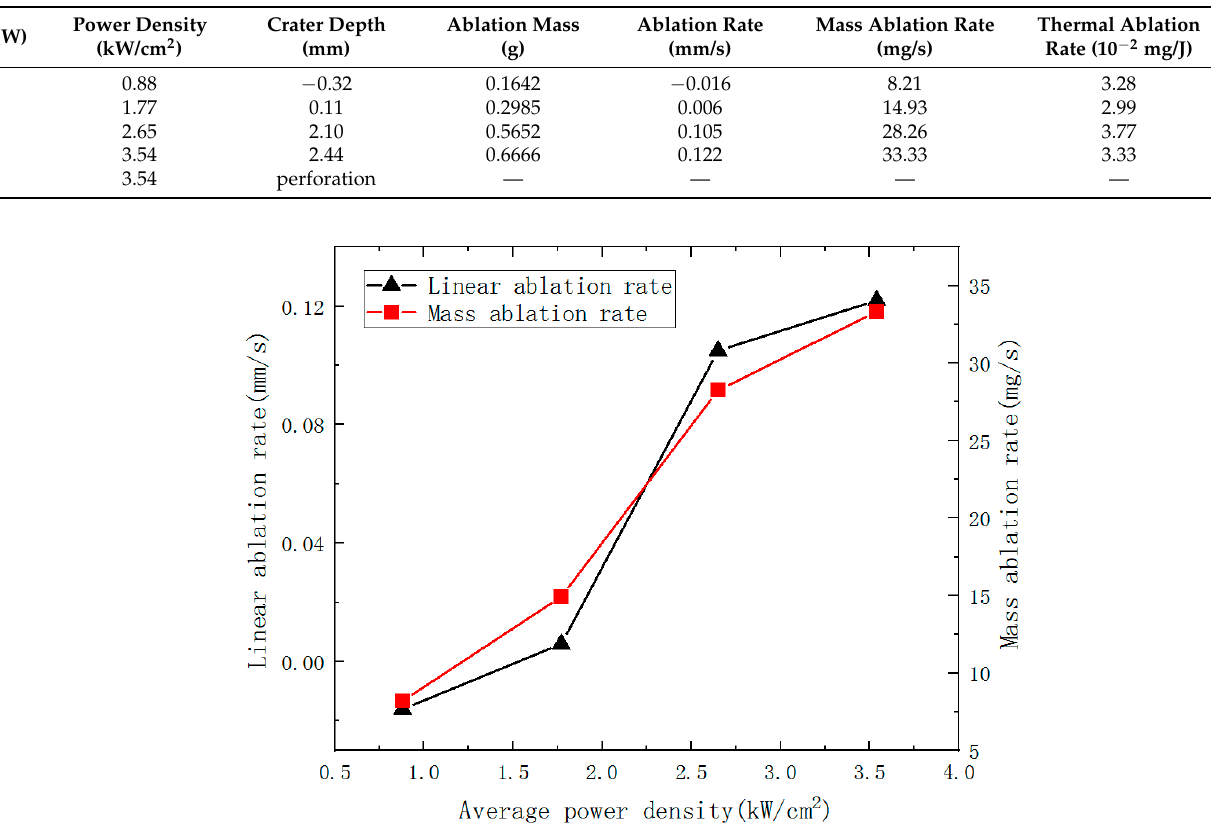
Figure 9. Time-of-flight images showing the distribution of delamination for CFRP laminates irra- diated by different laser power.